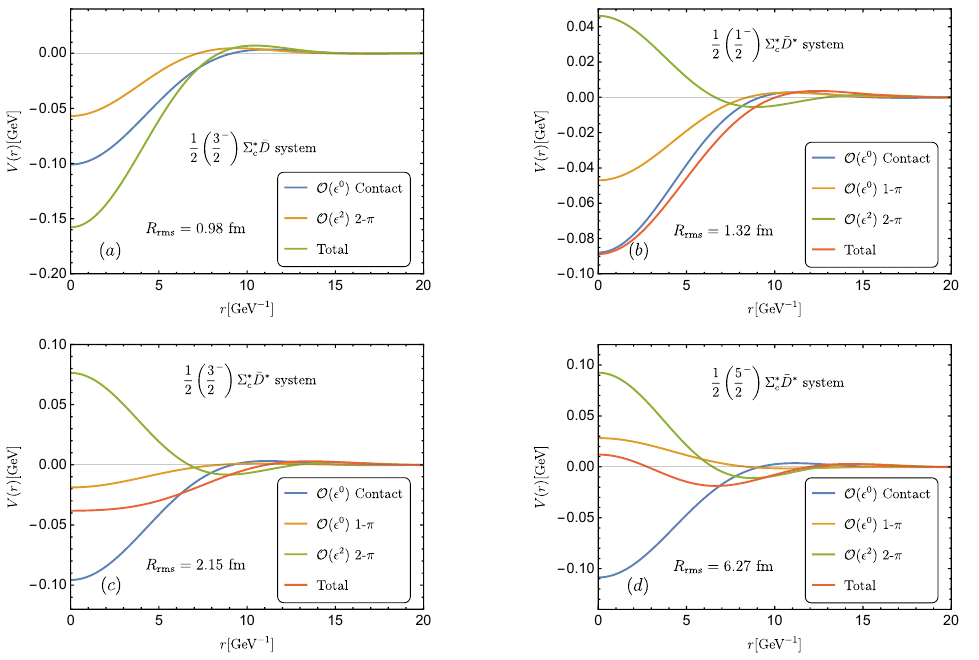
(cid:22) D ( (cid:3) ) systems. Their I ( J P ) are marked in each Figure 10 . The e(cid:11)ective potentials of the (cid:6) (cid:3) c sub(cid:12)gure. The potentials are obtained with the cuto(cid:11) parameter (cid:3) = 0 : 5 GeV, and the LECs (cid:0) 2 , D (cid:0) 2 . The R D 1 = 52 GeV 2 = (cid:0) 4 GeV rms in each sub(cid:12)gure denotes the root-mean-square radius of the corresponding